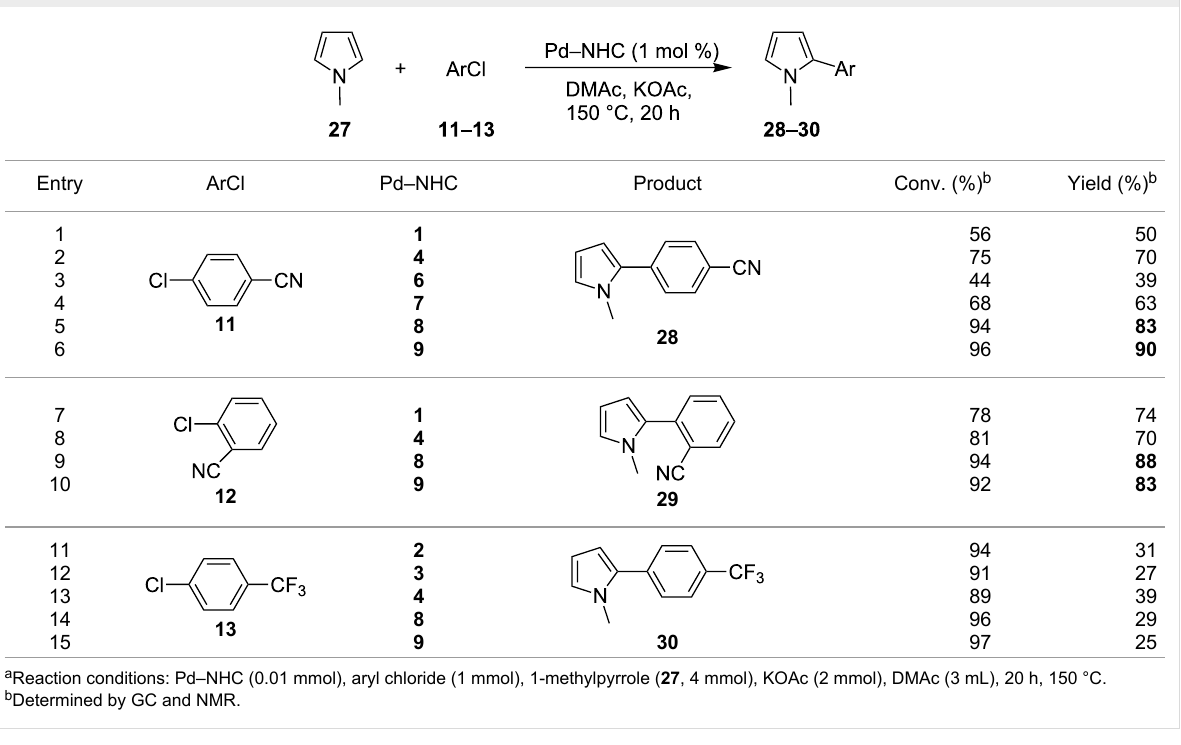
Table 4: Direct arylation of 1-methylpyrrole ( 27 ) with chlorobenzene derivatives. a